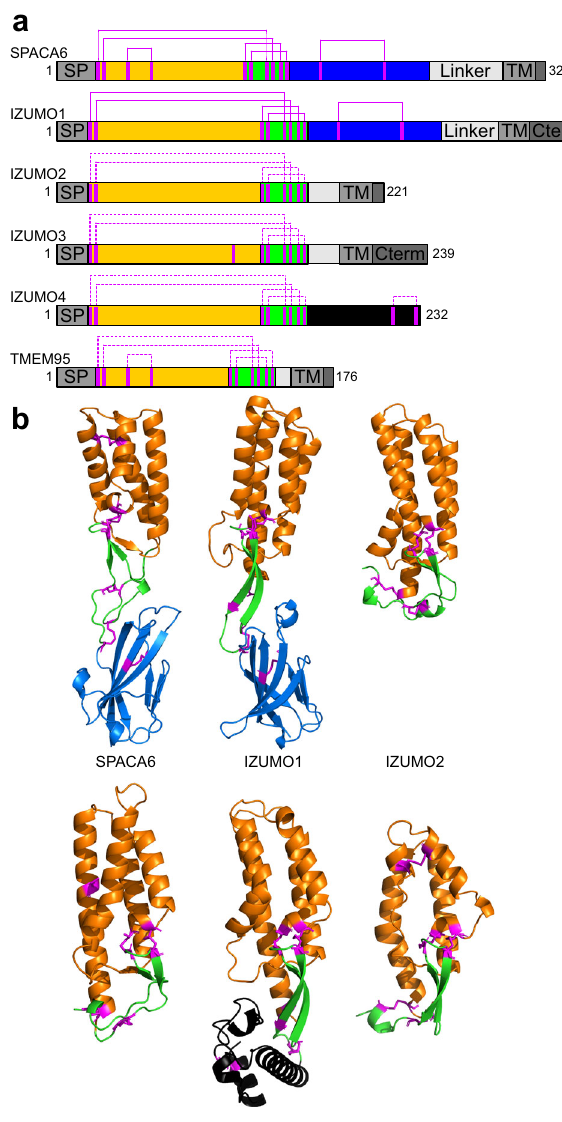
Fig. 3 SPACA6 and IZUMO1 are founding members of a fertilization- associated superfamily. a Domain architecture schematic of the IST superfamily with the 4HB, hinge, and Ig-like domains colored orange, green, and blue, respectively. IZUMO4 has a unique C-terminal region, which is colored black. Con fi rmed and putative disul fi de bonds are shown in solid and dashed magenta lines, respectively. b Ribbon diagrams of the IST superfamily of gamete fusion-associate proteins IZUMO1 (PDB: 5F4E), SPACA6, IZUMO2 (AlphaFold DB: AF-Q6UXV1-F1), IZUMO3 (AlphaFold DB: AF-Q5VZ72-F1), IZUMO4 (AlphaFold DB: AF-Q1ZYL8-F1), and TMEM95 (AlphaFold DB: AF-Q3KNT9-F1) shown in the same color scheme as in panel A. Disul fi de bonds are shown in magenta. Transmembrane helices of TMEM95, IZUMO2, and IZUMO3 are not